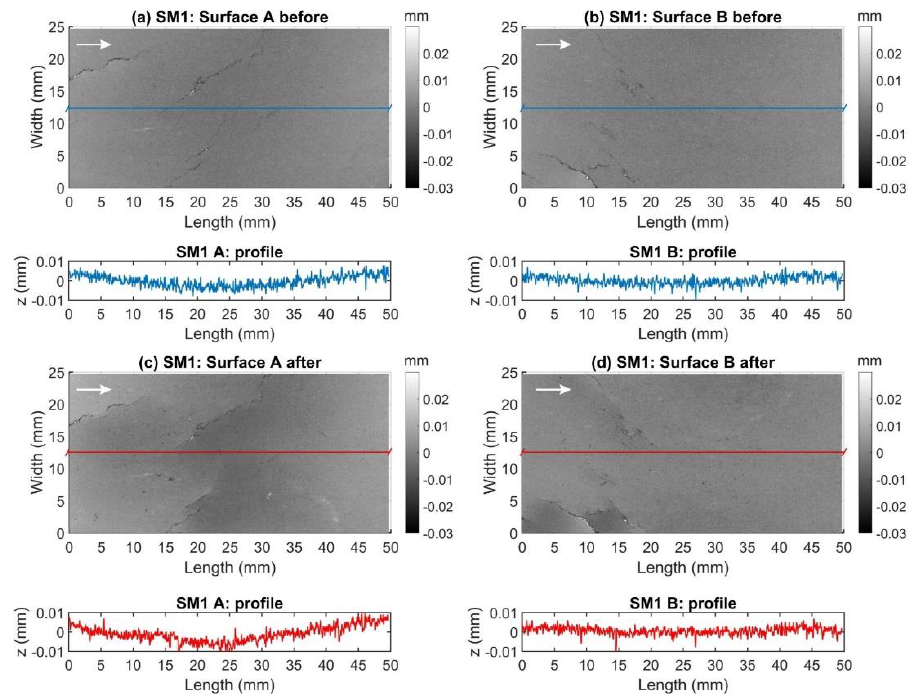
Figure A1. Fracture surface topographies and the central profiles of sample SM1 before ( a , b ) and after ( c , d ) the entire experiments, where the arrows indicate the flow direction.